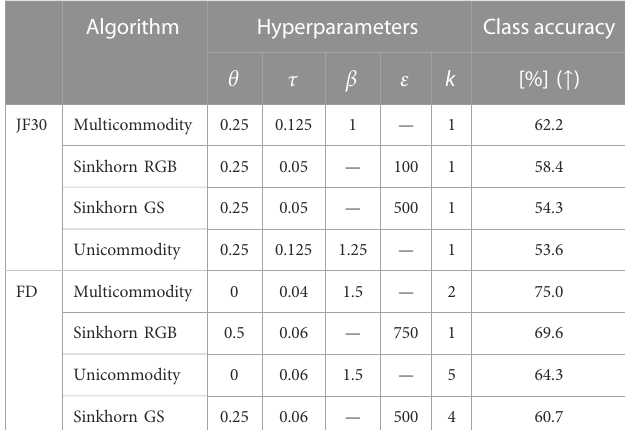
TABLE 1 Classi fi cation task results. With multicommodity, Sinkhorn RGB, unicommodity, and Sinkhorn GS, we label methods on colored images (the fi rst two) and grayscale images (the second two). The optimal parameters in the central columns are selected with a 4-fold cross-validation; k is the number of nearestneighborsusedintheclassi fi er.Therightmostcolumnshowsthefraction (in percentage) of correctly classi fi ed images. Results are ordered by performance, and we highlight the best ones in